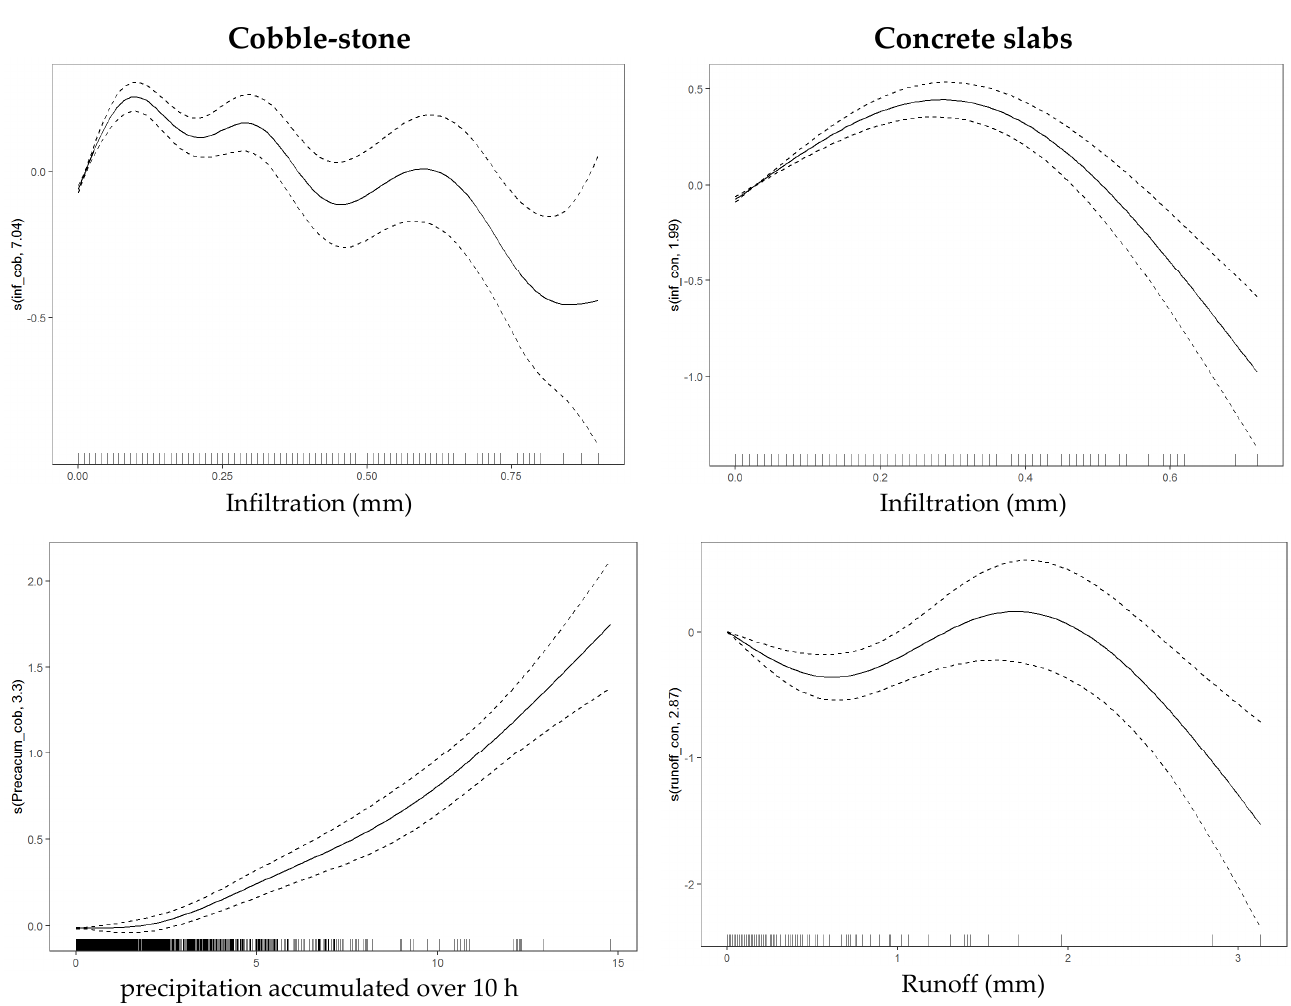
Figure 7. Explanatory variables that explain the variation of evaporation above cobble-stones and concrete slabs surfaces used in GAM model (2 and 3).